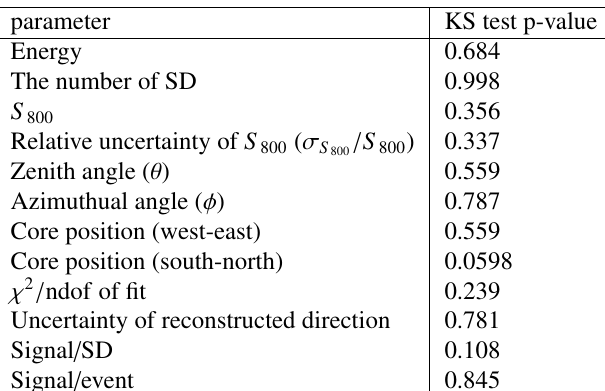
Table 1: Kolmogorov–Smirnov test p-value for parameters.